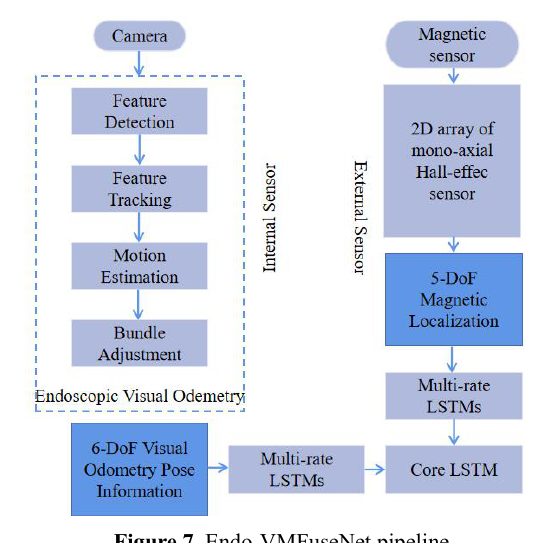
Figure 7. Endo-VMFuseNet